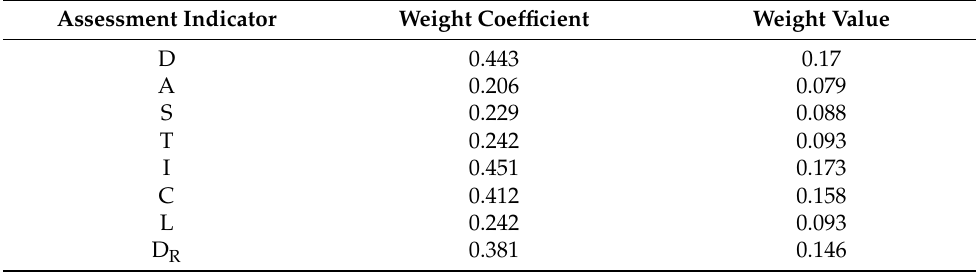
Table 3. Weight of each indicator in groundwater vulnerability assessment. Assessment